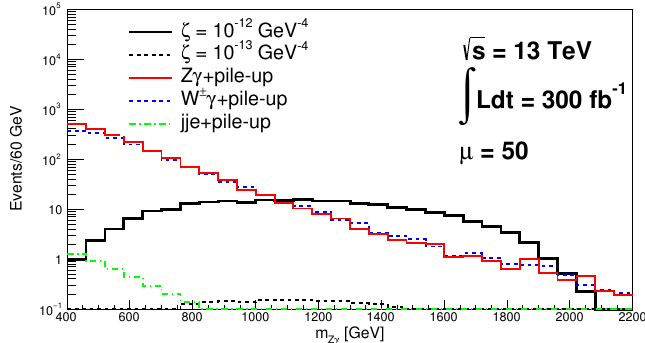
Figure 4 . (cid:13)Z mass distribution for the signal in the jj(cid:13) channel for two coupling values ( (cid:16) = 10 (cid:0) 12 ; 10 (cid:0) 13 GeV (cid:0) 4 , ~ (cid:16) = 0) for events within the 0 : 015 < (cid:24) 1 ; 2 < 0 : 15 proton detectors acceptance and after the transverse momenta requirement as in table 1. The plot assumes an integrated luminosity of 300 fb (cid:0) 1 and an average pile-up of (cid:22) = 50.